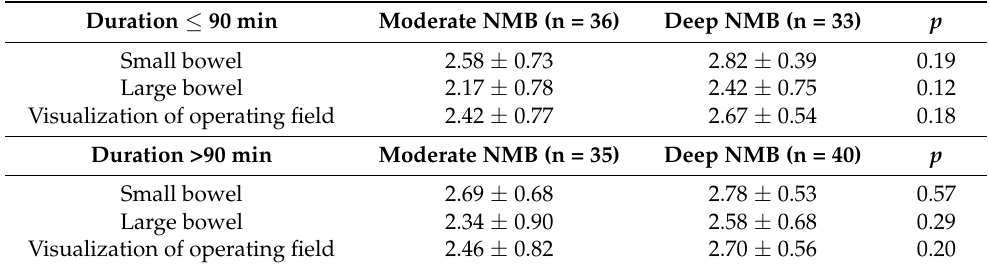
Table 3. Subgroup analysis of surgeons rating on operating field regarding to operations duration.